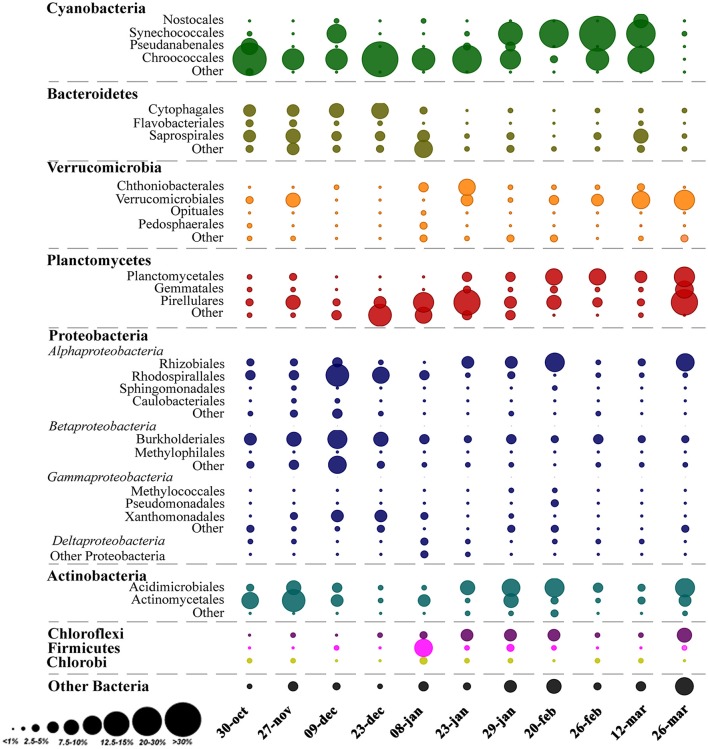
Relative abundance of OTUs classified as Order and Phyla across the sampling period. The area of the bubbles represents the relative abundance of OTUs (average values of the two sampling points). The color of the bubbles indicates the Phylum to which the OTUs were assigned.